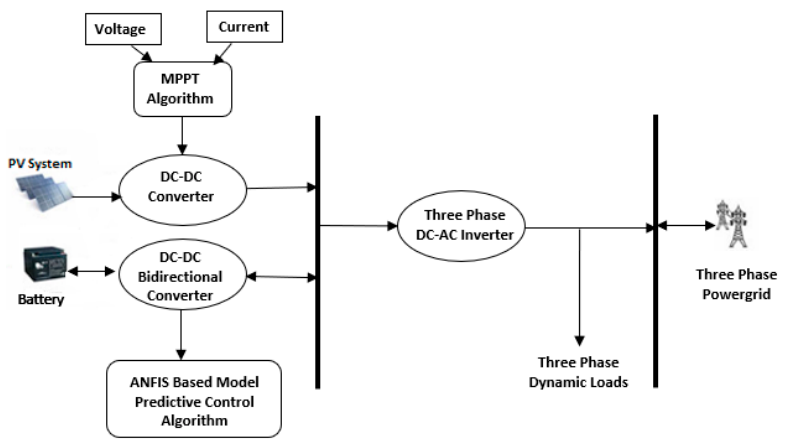
Figure 1. Structure of the designed microgrid system.